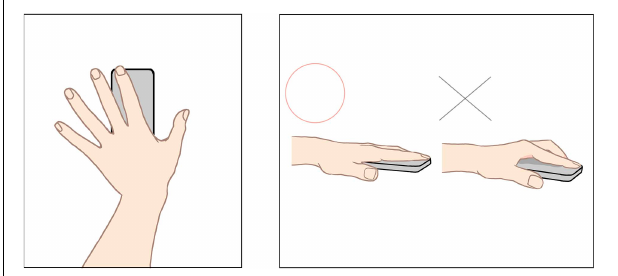
FIGURE 4 | Examples of images for the instruction of measuring PPG with smartphone used in the experiment in Study 2. The left part represents left hand on smartphone with the index finger covering the camera lens, seen from above. The right part represents good and bad example of measuring seen from the side, as the left one is favorable because the entire finger is in close contact with the smartphone while otherwise in the right one the index finger may get tired and shake, causing noise in the